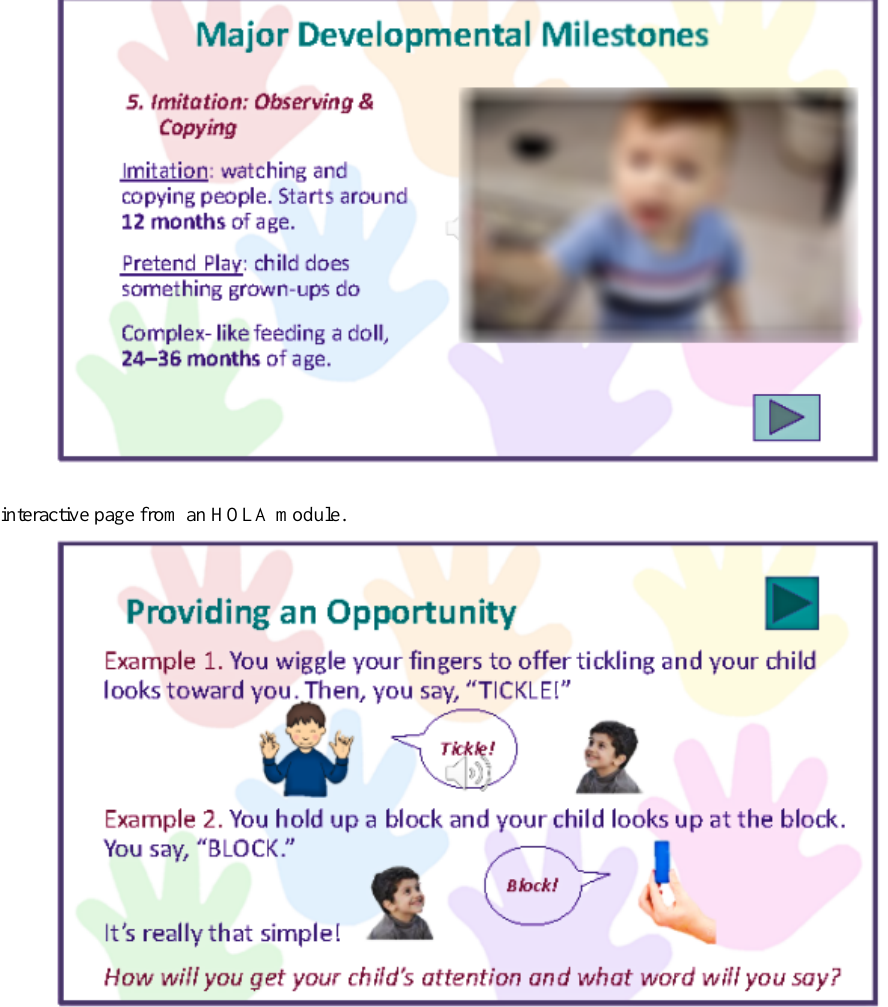
Figure 1. Example video enhanced page from an HOLA module.